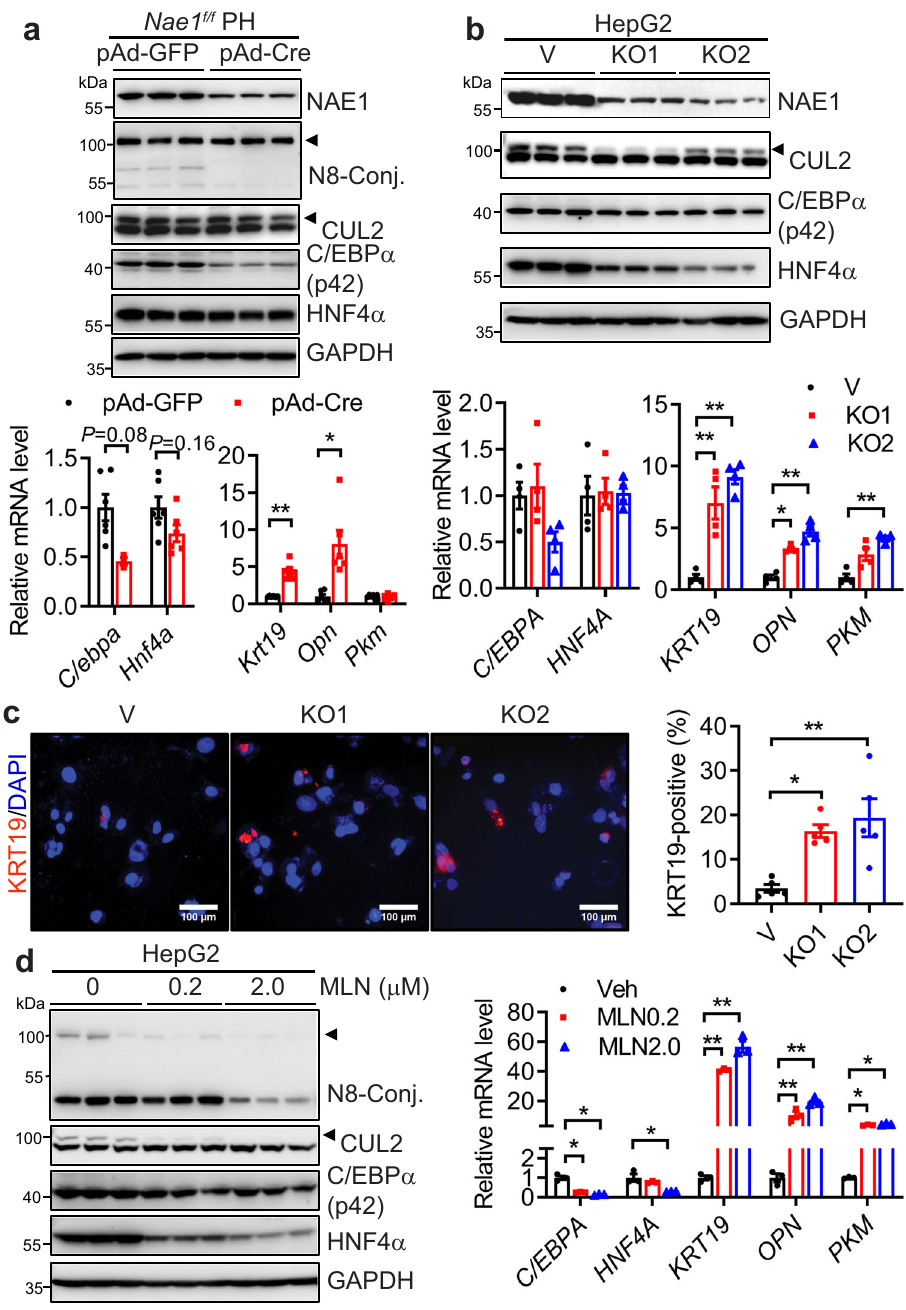
Fig. 5 | Neddylation de fi ciency autonomously activates hepatocyte fetal reprogramming. a Representative Western blot and relative mRNA levels of mature hepatocyte and BEC/ progenitor-speci fi c marker genes in mouse Nae1 f/f primary hepatocytes (PH) infected with pAd-GFP and pAd-Cre for 48h ( n =6 per group). pAd-GFP (black), pAd-Cre (red). Multiple unpaired t -tests with the Holm- Sidakmethod. b HepG2cellswereinfectedwithpLentiCRISPR/Cas9V2lentiviruses bearing two speci fi c human NAE1 sgRNAs to generate bulk cultures with NAE1 knockout (KO1 and KO2), respectively. Cells infected with viruses expressing no sgRNA were used as control (V). Western blot and relative mRNA levels of mature hepatocyte and BEC/progenitor-speci fi c marker genes were analyzed ( n =4 per